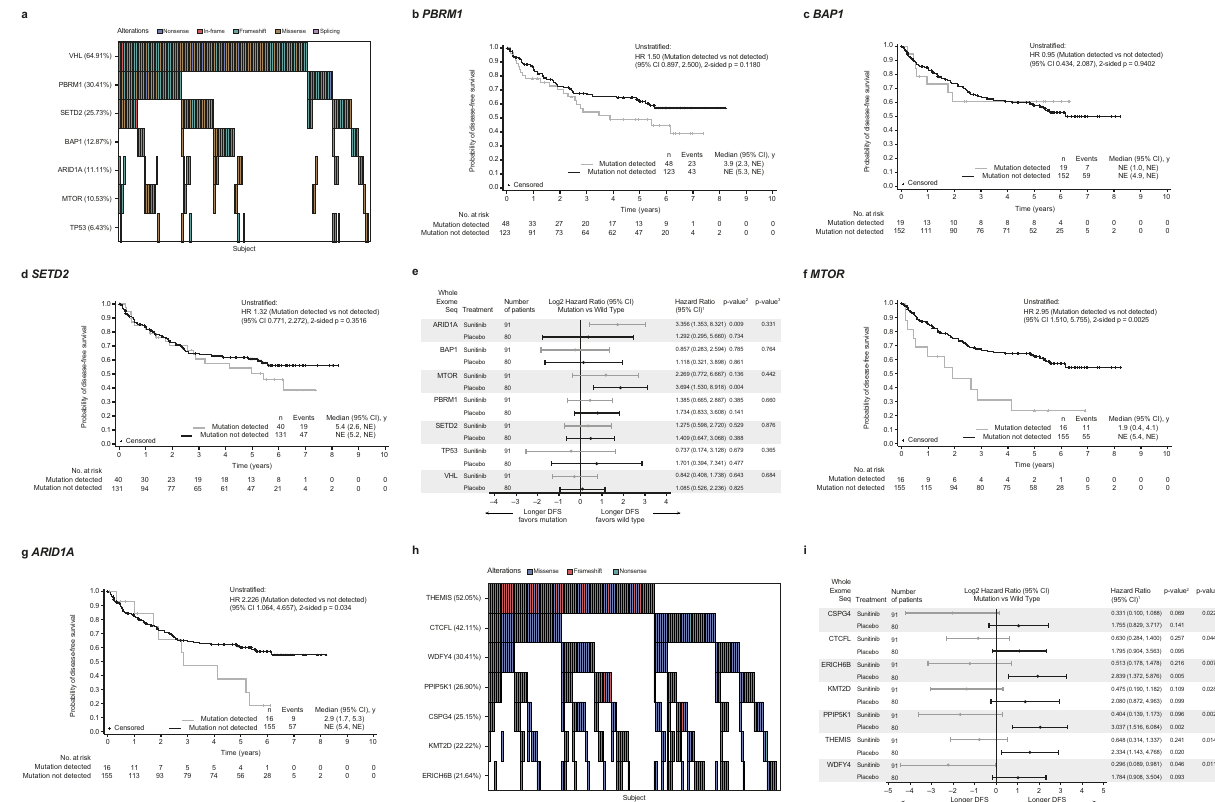
Fig.1|Mutationalanalysisofselectedgenes.a Heatmap ofselectedgenesbased on whole exome sequencing. Kaplan – Meier plots strati fi ed by mutation vs muta- tion not detected in the overall cohort for b PBRM1 ; c BAP ; and d SETD2 . e Forest plot for treatment arm effect of gene mutations and DFS association strati fi ed by mutation vs mutation not detected. Data are presented as hazard ratio (HR) and 95% CI. Kaplan – Meier plots strati fi ed by mutation vs mutation not detected in the overall cohort for f MTOR ; and g ARID1A . h Heatmap of gene mutations that in fl uenced sunitinib treatment outcome based on whole exome sequencing. i Forest plot for treatment arm effect of additional gene mutations and DFS asso- ciation strati fi ed by mutation vs mutation not detected. Data are presented as HR and 95% CI. HR<1 indicates longer DFS in mutation group; HR>1 indicates longer DFS in mutation not detected group. 1 Cox proportional hazards model with <median as the reference group was used to calculate HR and 95% CI. 2 Cox